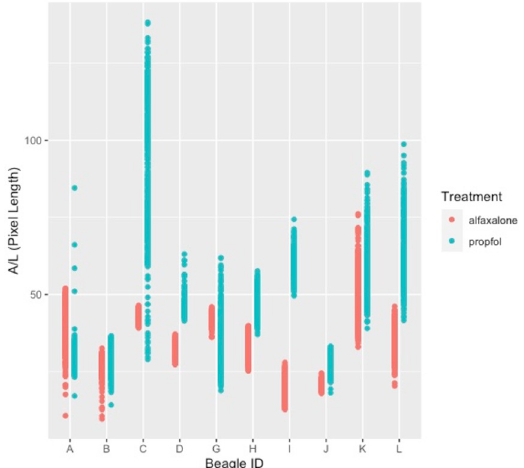
Fig 1. Bar chart for the variations (A/L) between dogs and different agents. The red bars indicate dogs receiving alfaxalone, and the blue bars indicate dogs receiving propofol.